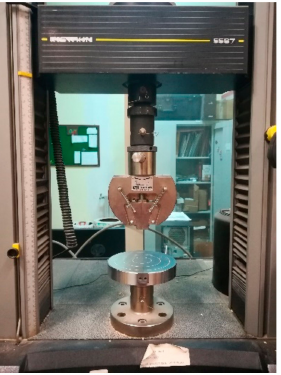
Figure 3. Universal testing